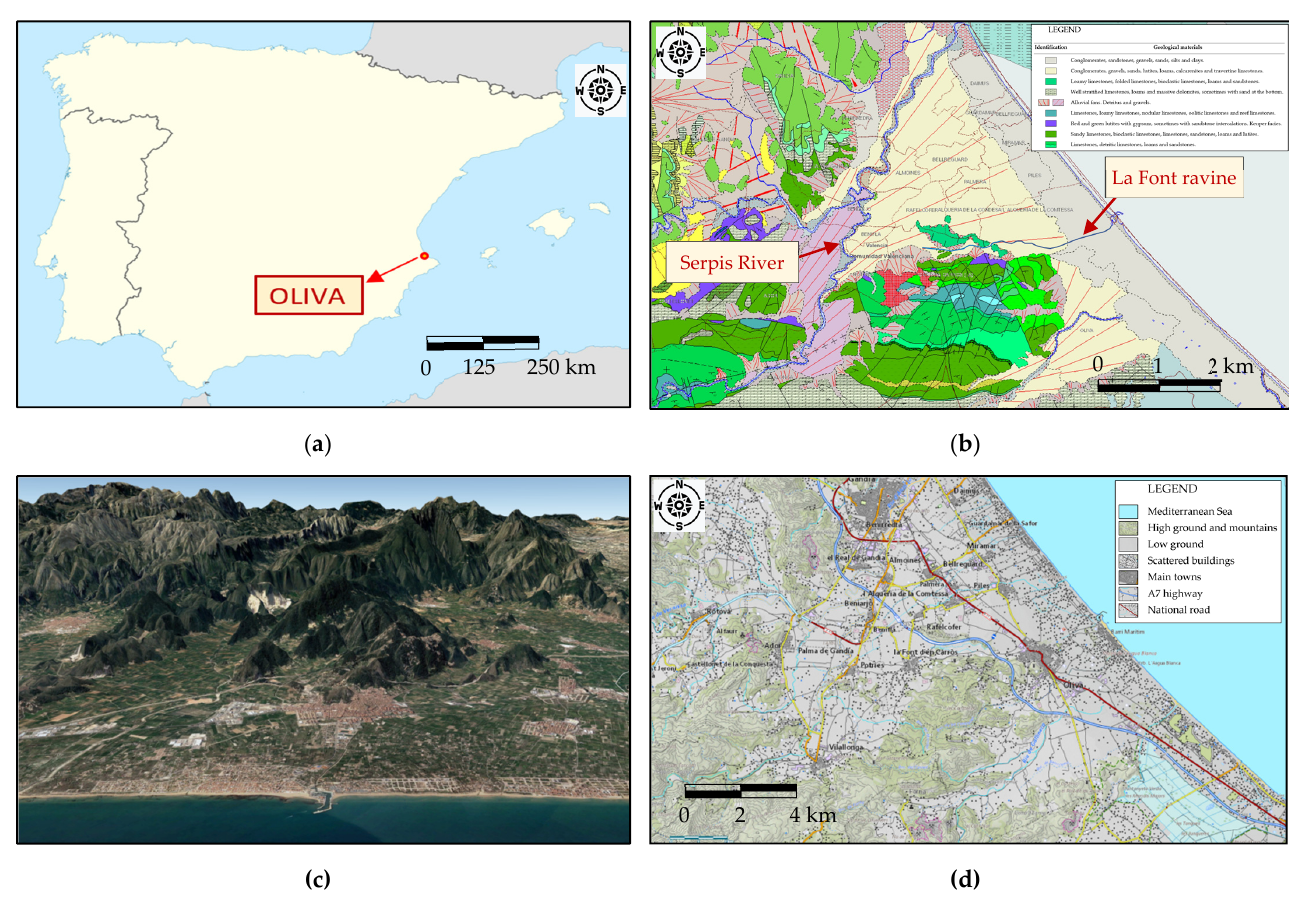
Figure 2. Geographical Setting and Geological Framework: ( a ) location of the town of Oliva; ( b ) geological framework in the area; ( c ) aerial view of the area under study (image from Landsat-Copernicus, data SIO, NOAA, US Navy, NGA, GEBCO, 2021, Google Earth); ( d ) urbanization of the area. All maps are oriented to the North. An extended larger version of Figure 2b,d can be found in the supplementary material.